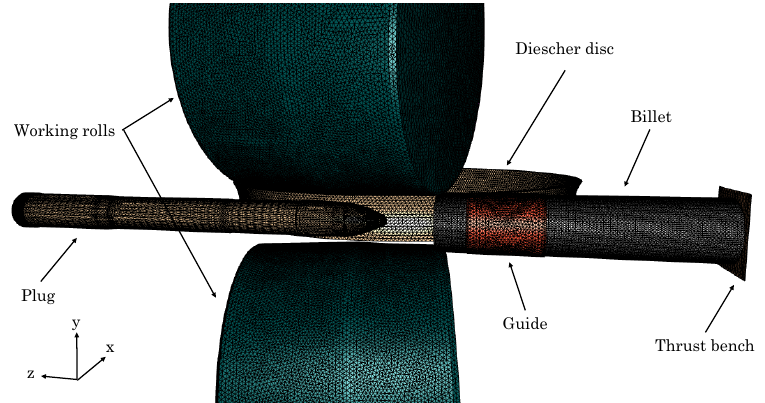
Figure 5. Layout of the rotary tube piercing mill (one of the Diescher discs is not represented).